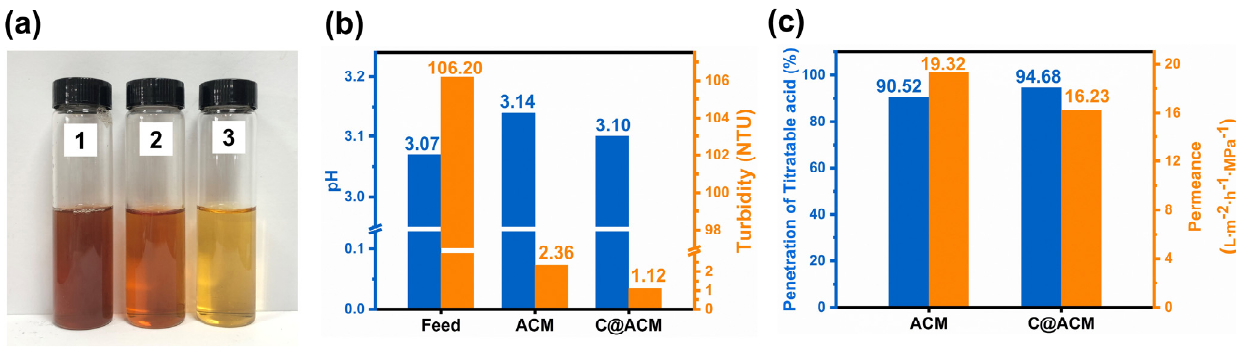
Figure 10. Properties of hawthorn extract after membrane treatment: ( a ) The photos of hawthorn extract: 1. feed, 2. ACM permeate, 3. C@ACM permeate; ( b ) pH and turbidity of the feed and permeates; ( c ) The flux and penetration of titratable acid.